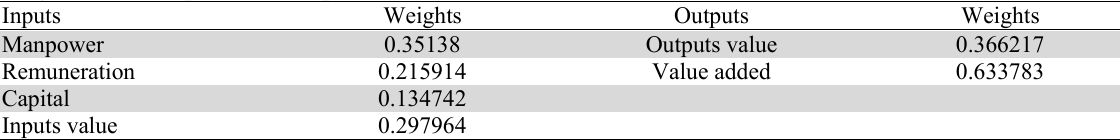
Weights of the inputs and output